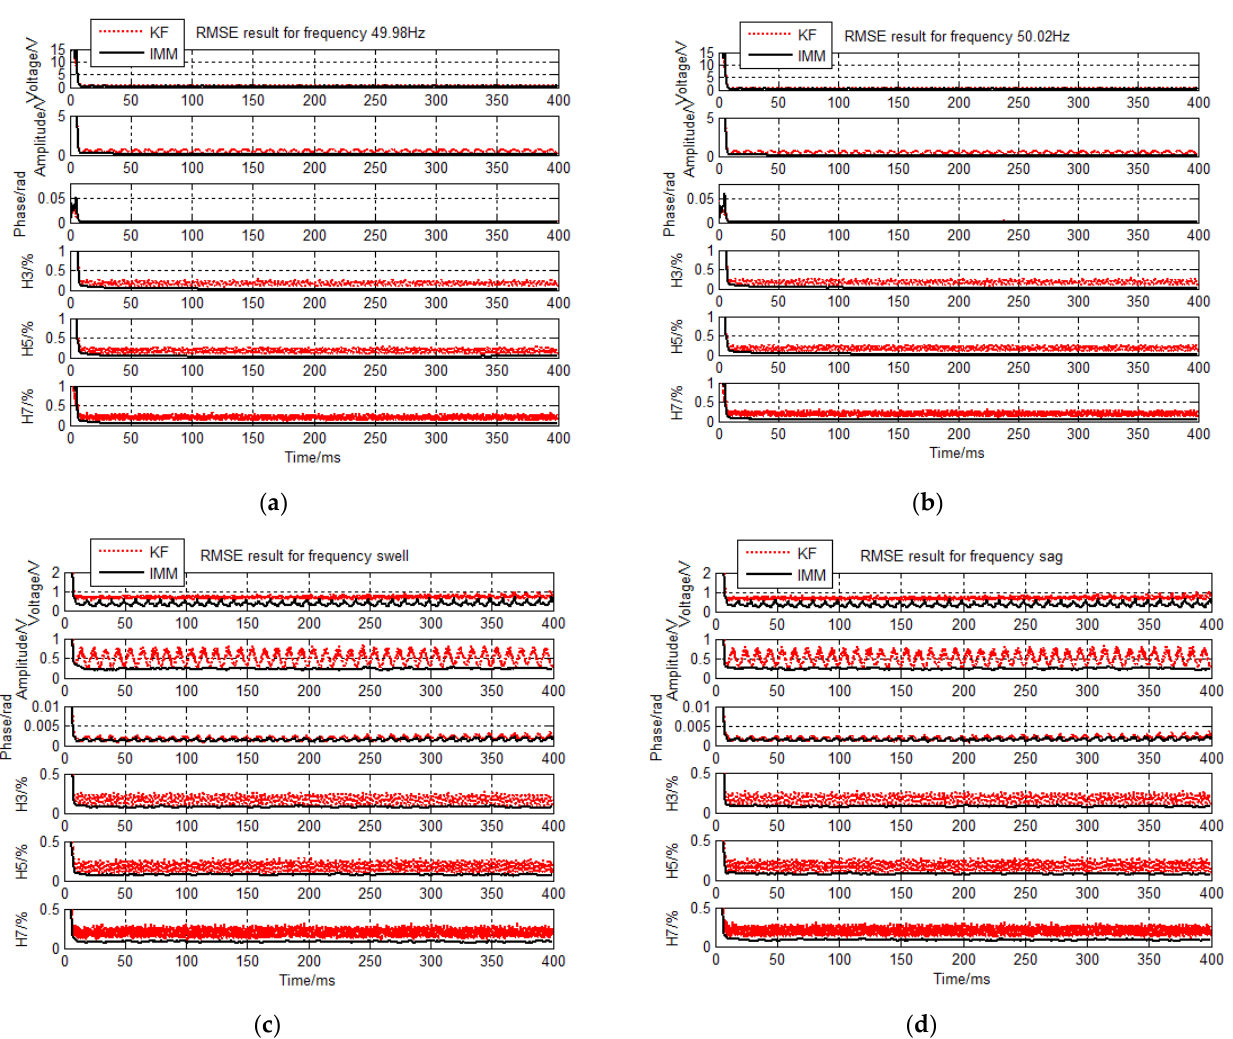
Figure 9. Simulation RMSE results for voltage frequency heavy fluctuations. ( a ) Simulation RMSE results for frequency 49.5 Hz; ( b ) Simulation RMSE results for frequency 50.5 Hz; ( c ) Simulation RMSE results for frequency swell ; ( d ) Simula- tion RMSE results for frequency sag.